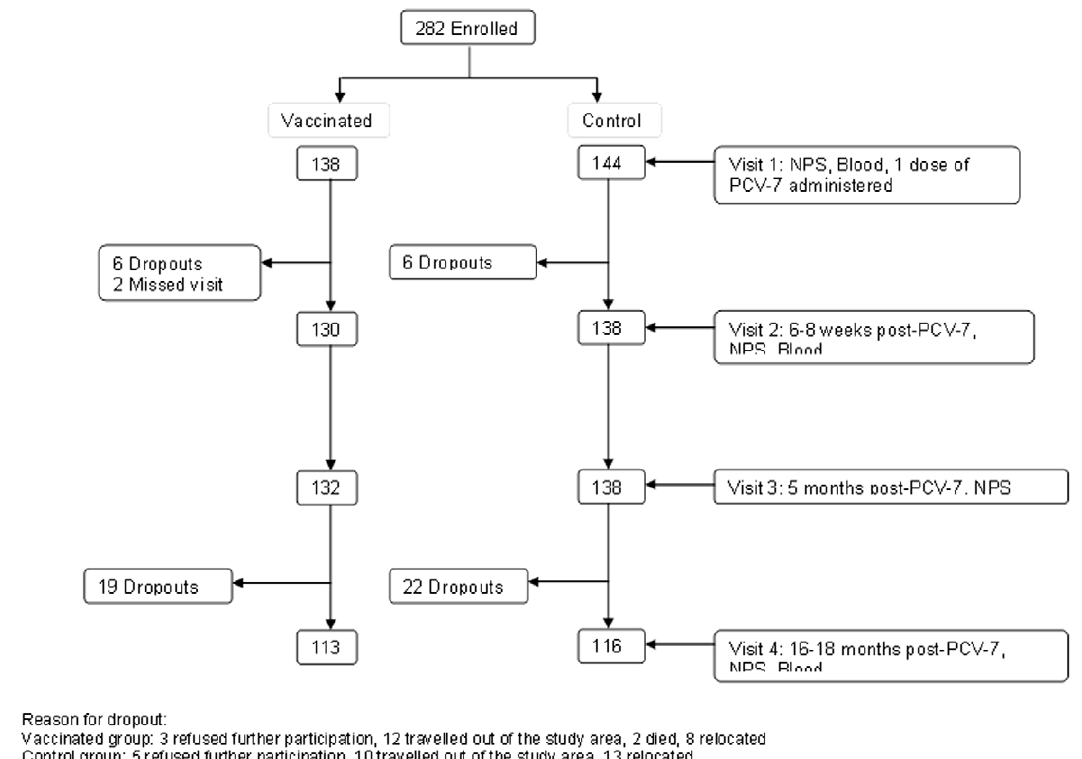
Figure 1. A consort diagram indicating number of study participants per study group and visit.